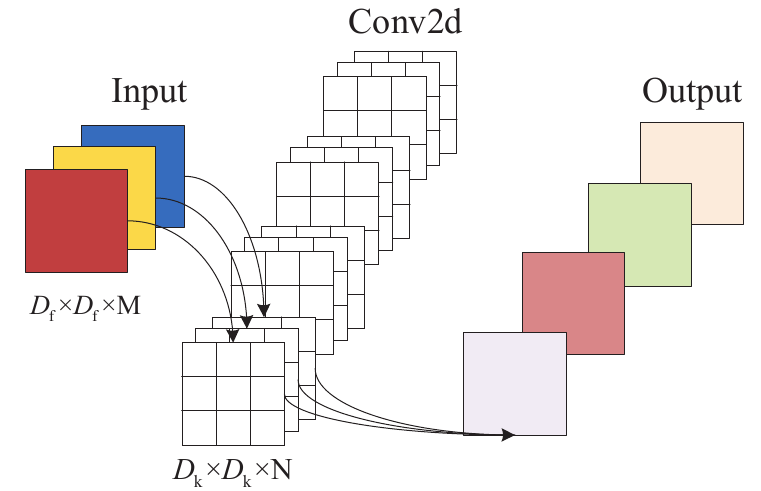
Figure 2. Ordinary convolution structure.